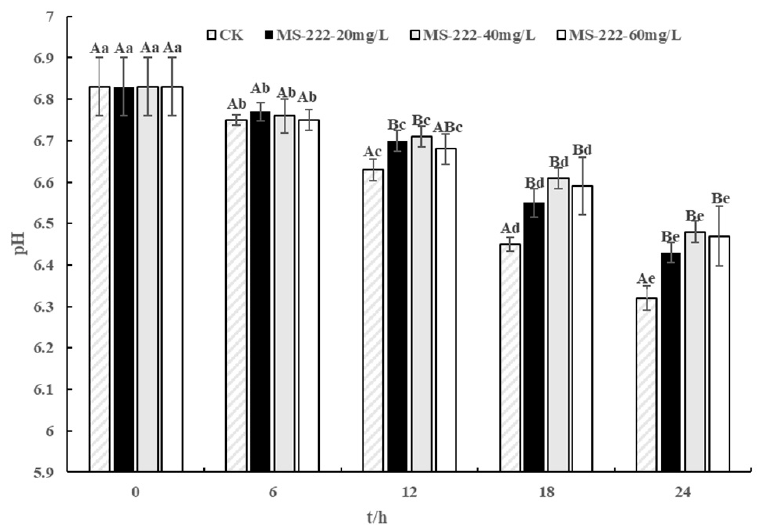
Figure 1. Flesh pH of turbot fillets as affected by simulated transport stress. Different capital letters indicate significant differences in the average between groups. Different lowercase letters indicate significant differences in the average value within each group ( p < 0.05). CK, control group.